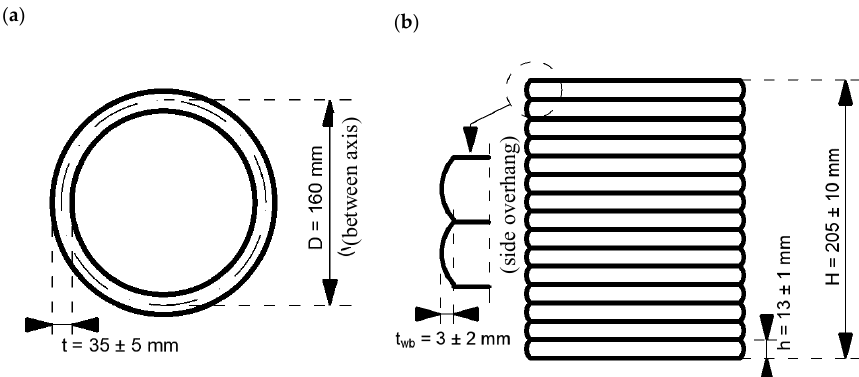
Figure 3. Plan ( a ) and side view ( b ) of printed columns.